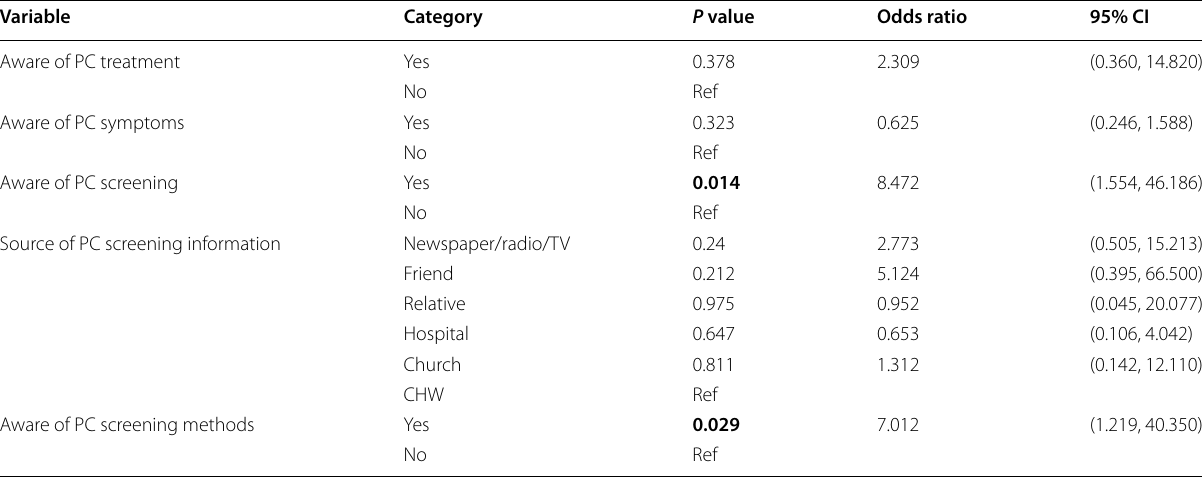
Ref reference; CI confidence